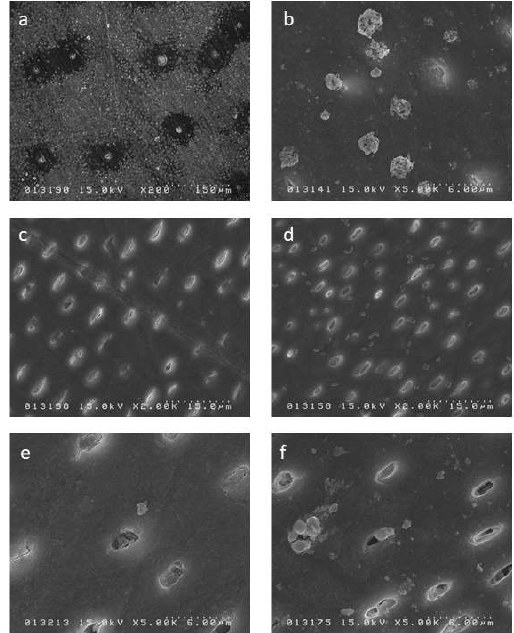
Figure 6. SEM image for the surface of the dentin specimens: ( a ) SDF 24 h; ( b ) SDF 2 weeks; ( c ) SDF + GSH 24 h; ( d ) SDF + GSH 2 weeks; ( e ) SDF + KI 24 h; and ( f ) SDF + KI 2 weeks.